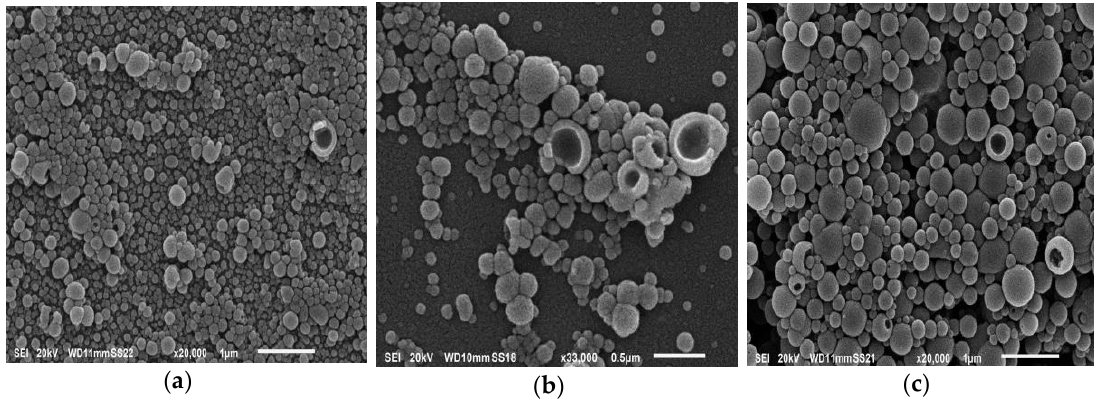
Figure 1. SEM images of catalyst I and catalyst II . ( a ) General overview of catalyst I ; ( b ) Selected magnification of catalyst I ; ( c ) General overview of catalyst II .